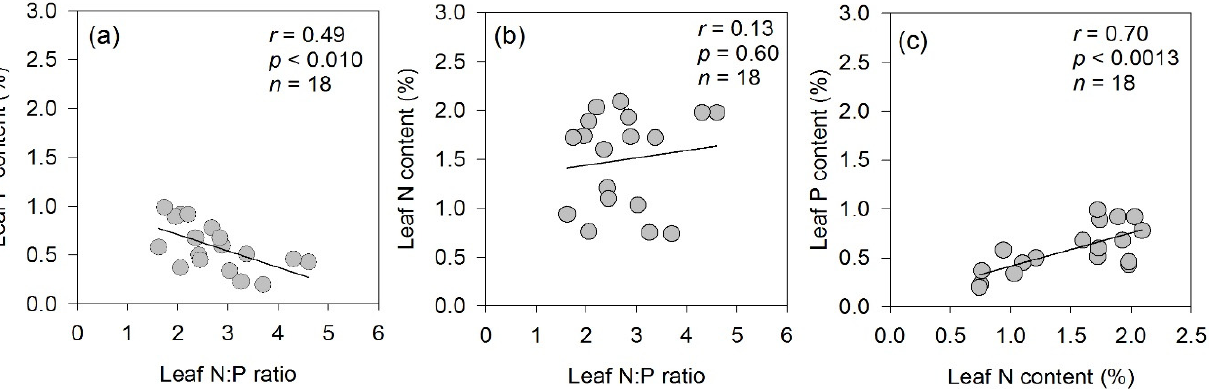
Figure 3. Relationships between leaf P ( a ), leaf N ( b ), and leaf N:P ratios and between leaf P and leaf N ( c ) content of the dominant tree species found in ultramafic areas affected by mining activities in Hinatuan Island, Taganaan, Surigao Del Norte, Philippines.